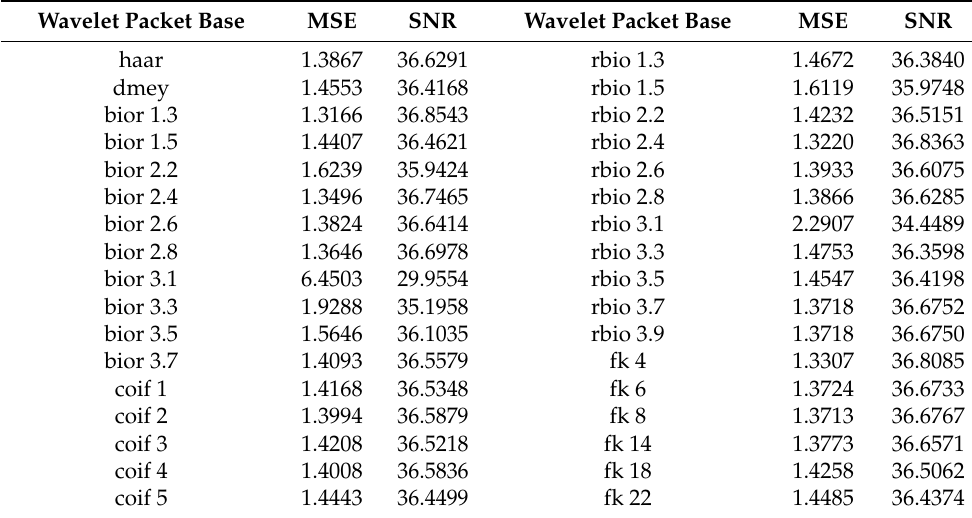
Figure 10. The SNR fit curve of the sym wavelet packet base. The values of the MSE and SNR of Haar (haar), Dmeyer (dmey), BiorSplines (bior), ReverseBior (rbio), Coiflets (coif), and the Fej é r–Korovkin (fk) finite order wavelet packet base are shown in Table 7. Table 7. The MSE and SNR of the haar, dmey, bior, rbio, coif, fk wavelet packet